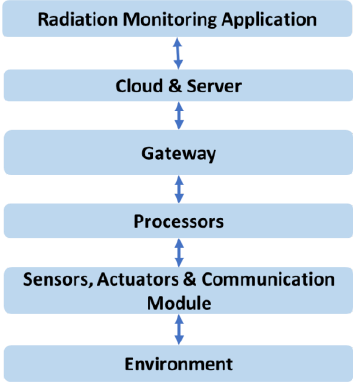
Figure 4. General layers of Internet of Things in radiation monitoring.